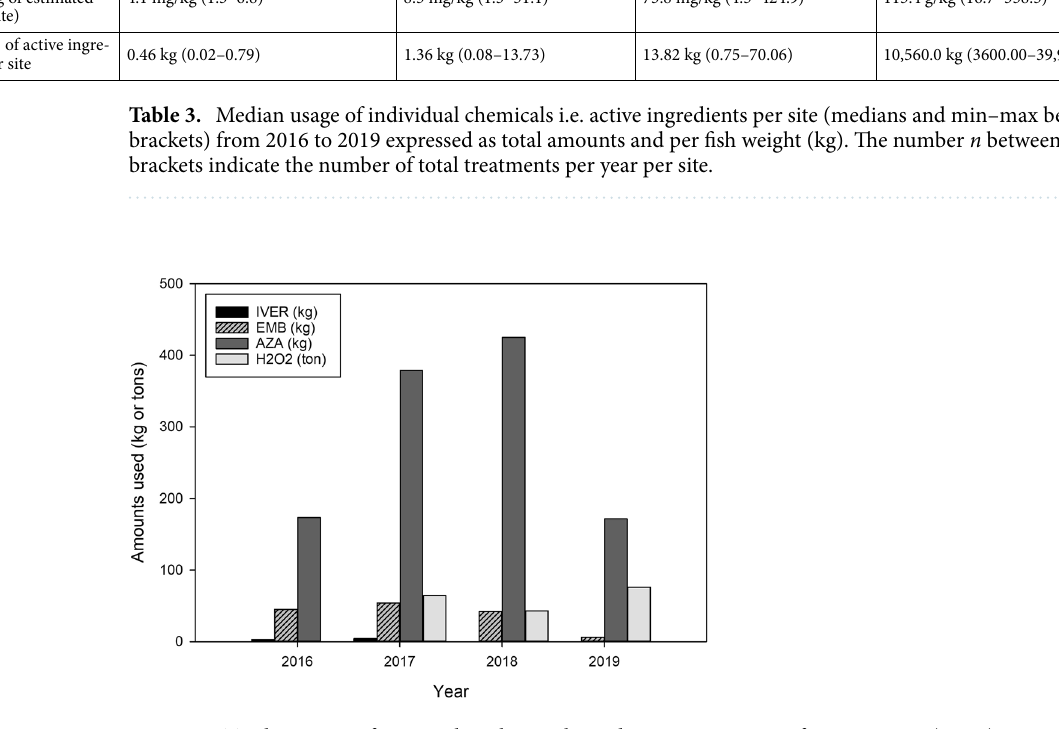
Figure 2. Total amounts of anti-sea lice chemicals used per year. Amounts for Ivermectin (IVER), EMB, Azamethiphos (AZA) are expressed in kgs. Hydrogen peroxide (H2O2) amounts are in